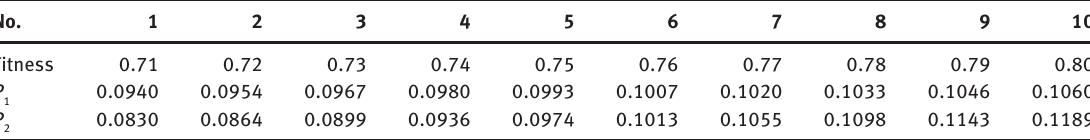
is Equal to 50. c